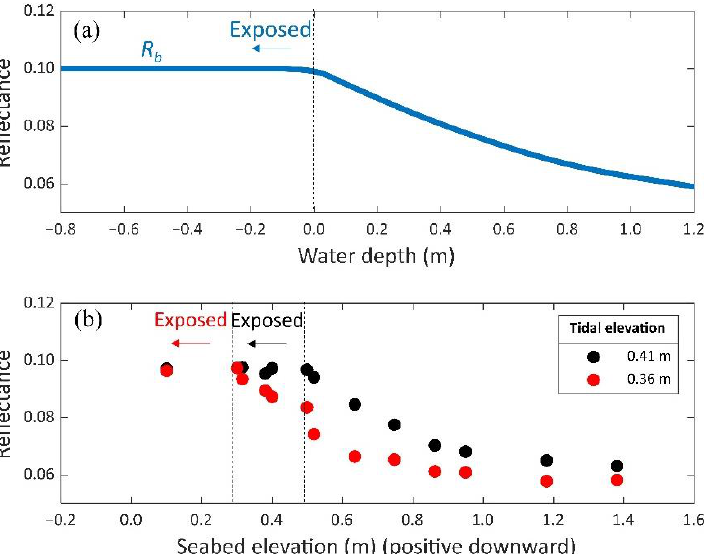
Figure 3. ( a ) The theoretical dependence of R on water depth according to Equation (1). In this example, K d was set to 0.5 m − 1 , R b was 0.11, R w was 0.028, and the inundated region was at a water depth greater than 0 m. ( b ) Examples of the observed reflectance from the transect shown in Figure 1 in Band 2 (blue) plotted against seabed elevation for two different tides (in which the tidal elevation is 0.41 m and 0.36 m below mean sea level).